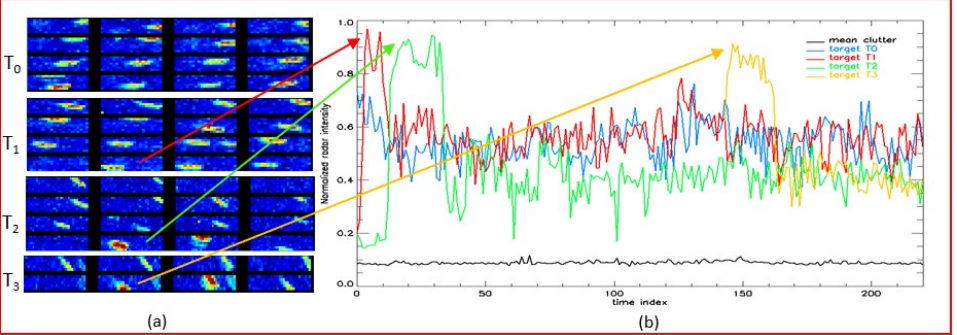
Figure 9. ( a ) Sequence of the sub-areas containing the targets; ( b ) trend of the radar intensities of the